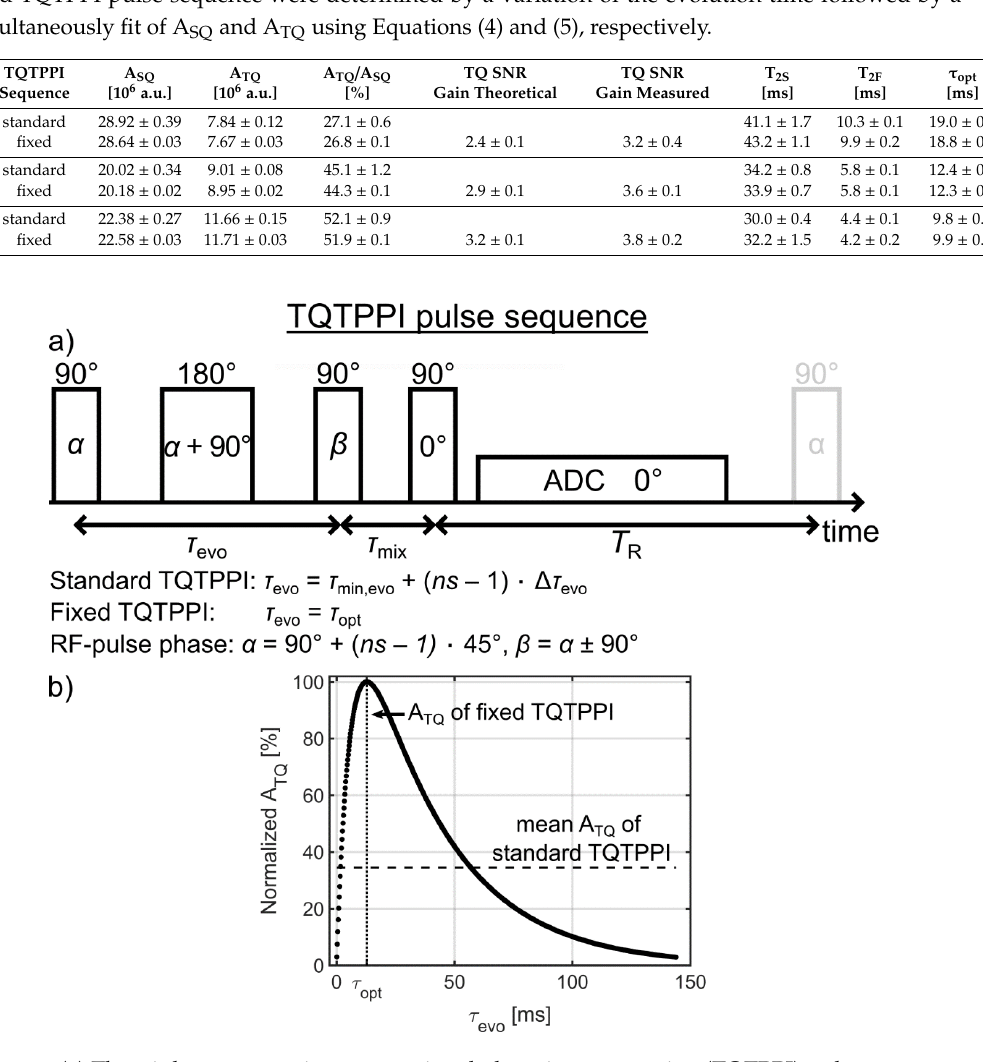
Figure 3. ( a ) The triple-quantum time proportional phase incrementation (TQTPPI) pulse sequence. In the standard TQTPPI pulse sequence, the radiofrequency (RF) phase α = 90° + (ns – 1) × 45° and the evolution time τ evo = τ min,evo + (ns – 1) × Δτ evo are simultaneously incremented. For the proposed fixed TQTPPI pulse sequence, the evolution time is optimized and fixed throughout the pulse sequence. The RF phase of the second 90° RF pulse β = α ± 90° was alternated and the output signals were added during each phase increment α to suppress double-quantum (DQ) signals. ( b ) Exemplary buildup of the TQ signal using the relaxation times of the sample with 4% agarose in 134.75 mM NaCl triple-quantum (TQ) free induction decay (FID). This results in a lower mean A TQ amplitude